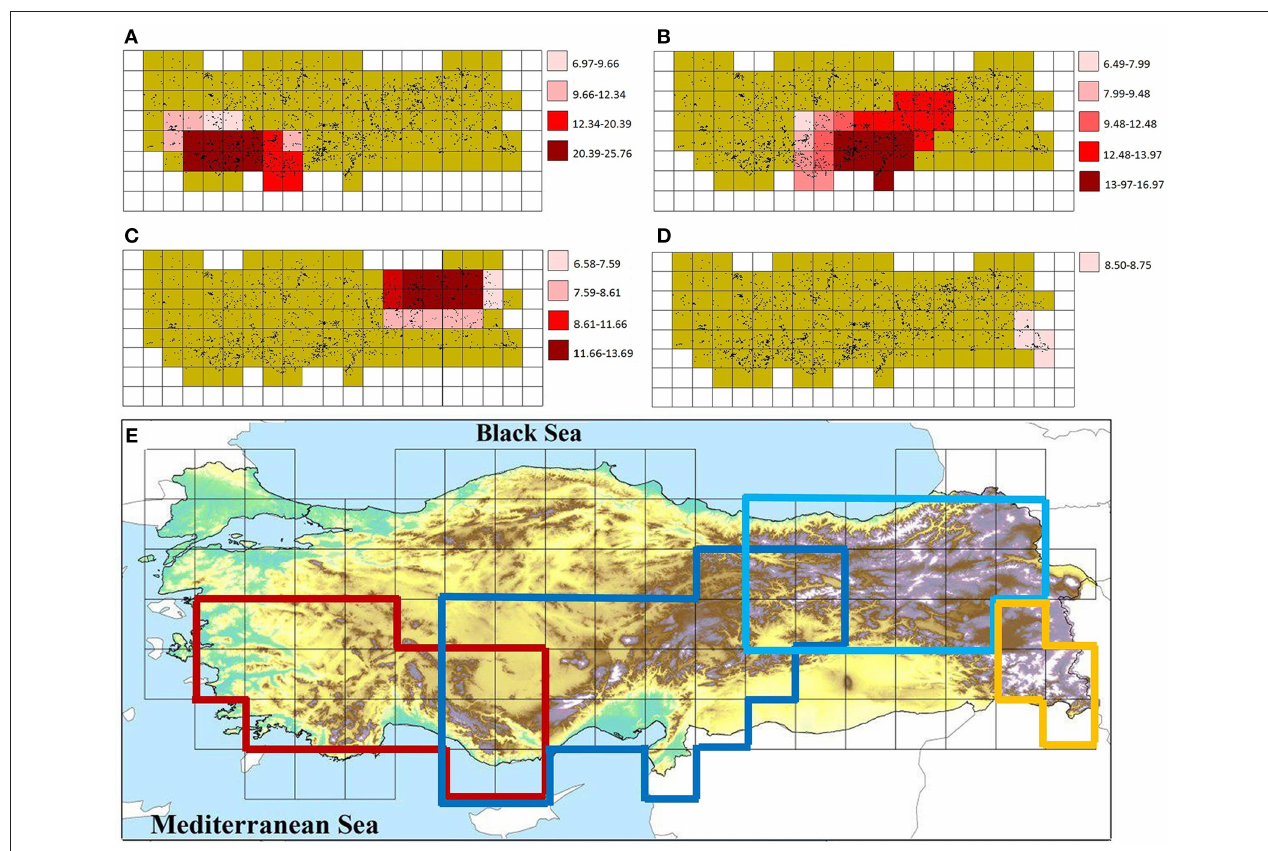
FIGURE 3 | Areas of endemism (AEs) in the study area (A) West-Taurus AE, (B) Anatolian Diagonal AE, (C) Pontic-Ala AE, (D) Hakkari AE, and (E) their overlap. Dots in (A–D) indicate the data points used in this